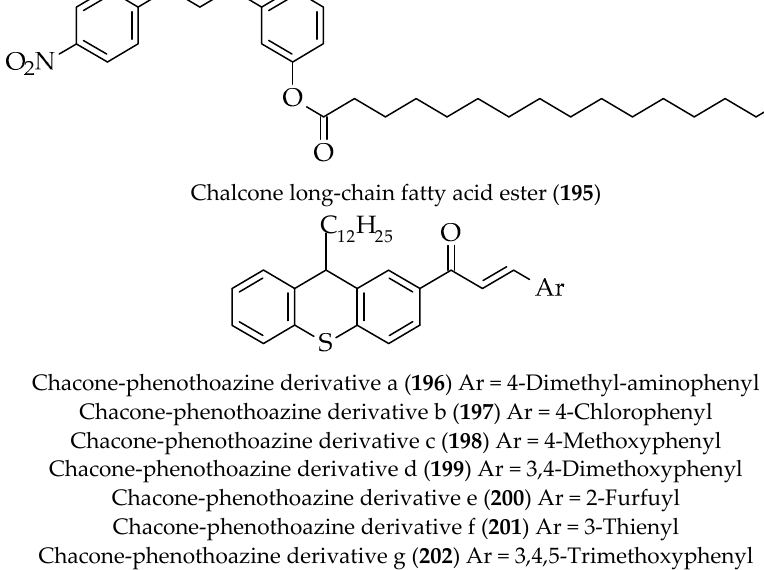
Figure 17. Structures of some synthetic antioxidant chalcones.